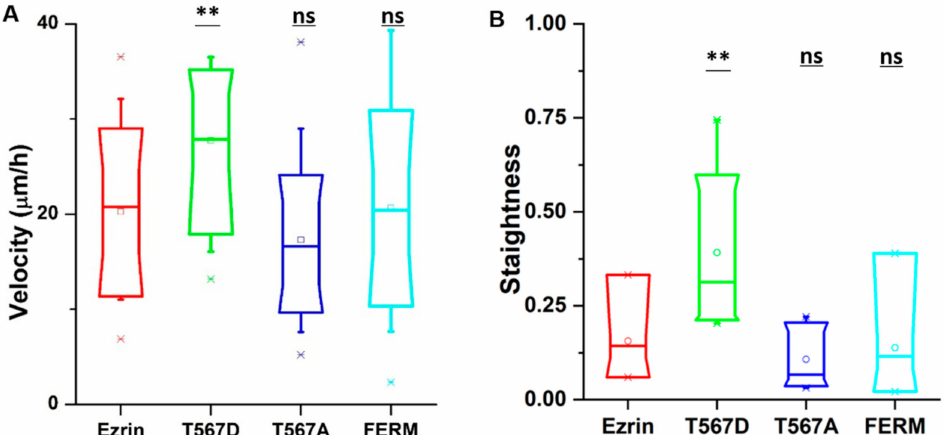
Figure 1. The e ff ect of ezrin mutations on cell migration. NIH 3T3 cells were transfected with wild-type ezrin (red), ezrin T567D (green), ezrin T567A (blue), or FERM domain (cyan). Transfected cells were used for a migration experiment and (Atomic Force Microscope) AFM experiment. Box plots show the results of migration velocity ( A ) and migration directionality ( B ). Box plots extend from the 10th to the 90th percentile, whiskers from the 5th to the 95th. A total of n = 21 (ezrin), n = 45 (ezrin T567D), n = 2 (ezrin T567A), and n = 60 (FERM) cells were analyzed from n = 4 repeats. Asterisks indicate a statistical di ff erence (* p < 0.05, ** p < 0.01, *** p < 0.001, obtained using Dunnett’s test against wild-type